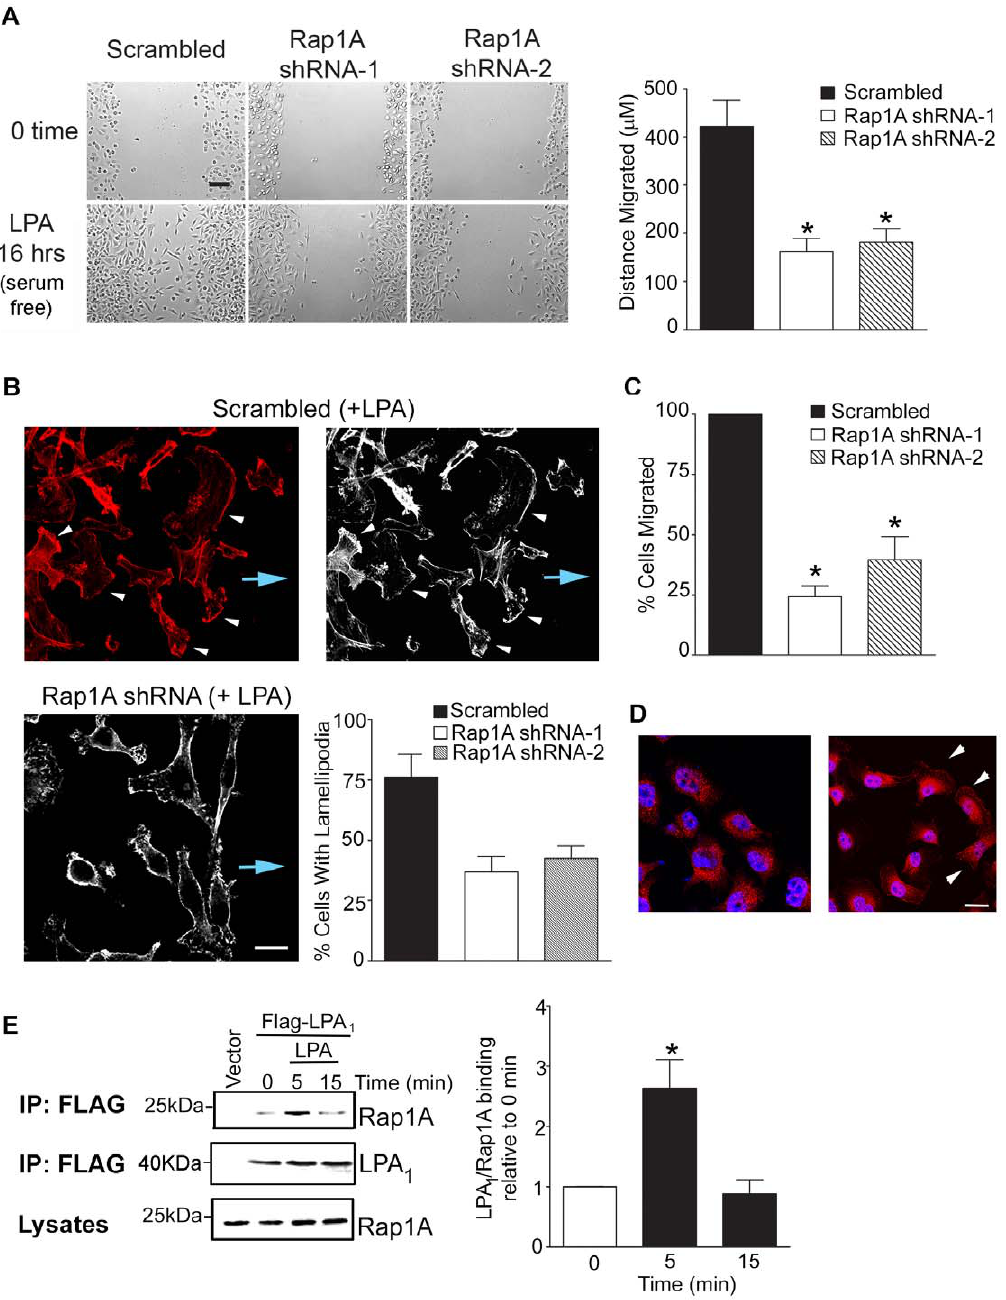
Figure 3. Rap1A associates with LPA 1 and regulates breast cancer cell migration. (A) Depletion of Rap1A expression significantly blocks scratch closure of MDA-MB-231 cells in response to LPA treatment. Cells were grown to confluence, serum starved for four hours and scratched with a sterile pipette tip. Serum-free medium containing 10 m M LPA was added to the cells which allowed to migrate into the scratch for 16 hours and visualized using an IX-81 Olympus microscope. Cell migration was quantitated using ImagePro software and bars represent the mean distance travelled (in m m) after 16 hours of culturing in LPA. Data from four experments.*, p , 0.05, scale bar = 100 m m. (B) LPA (10 m M) stimulates lamellipodia formation at the leading edge of motile MDA-MB-231cells expressing scrambled shRNA (control, upper panels) in a scratch assay. The effect of depleting endogenous Rap1A from LPA-stimulated cells is shown (lower panel). Cells, grown to confluency were serum starved for 4h and scratched with a sterile pipette tip. Cells were then placed in media containing LPA and allowed to migrate into the scratch for 4 hours, fixed, permeabilized, immunostained and visualized using confocal microscopy. Alexa-Fluor 555 conjugated phalloidin (red) was used to stain F-actin. Loss of color (grayscale image) shows the lamellipodia at the leading edge (white arrowheads). Direction of cell migration shown by blue arrow. Scale bar, 20 m m. Quantitation of cells with lamellipodia was carried out as described under ‘‘Materials and Methods’’ and graphed. Error bar, SEM *, p , 0.05. Data from three independent experiments. (C) Migration of serum-starved, Rap1A-depleted MDA-MB-231 cells towards 10 m M LPA is significantly inhibited, as determined by Transwell chamber assays. *, p , 0.05. Data from four experments. (D) Confocal micrographs showing the localization of LPA 1 in MDA- MB-231 cells stably expressing FLAG-LPA 1 subjected to a scratch assay, as described above. Immunostaining for FLAG (red) with a rabbit anti-FLAG antibody; nuclei were stained using Hoechst 33258. (E) LPA 1 interacts with endogenous Rap1A. Co-immunoprecipitation studies were performed